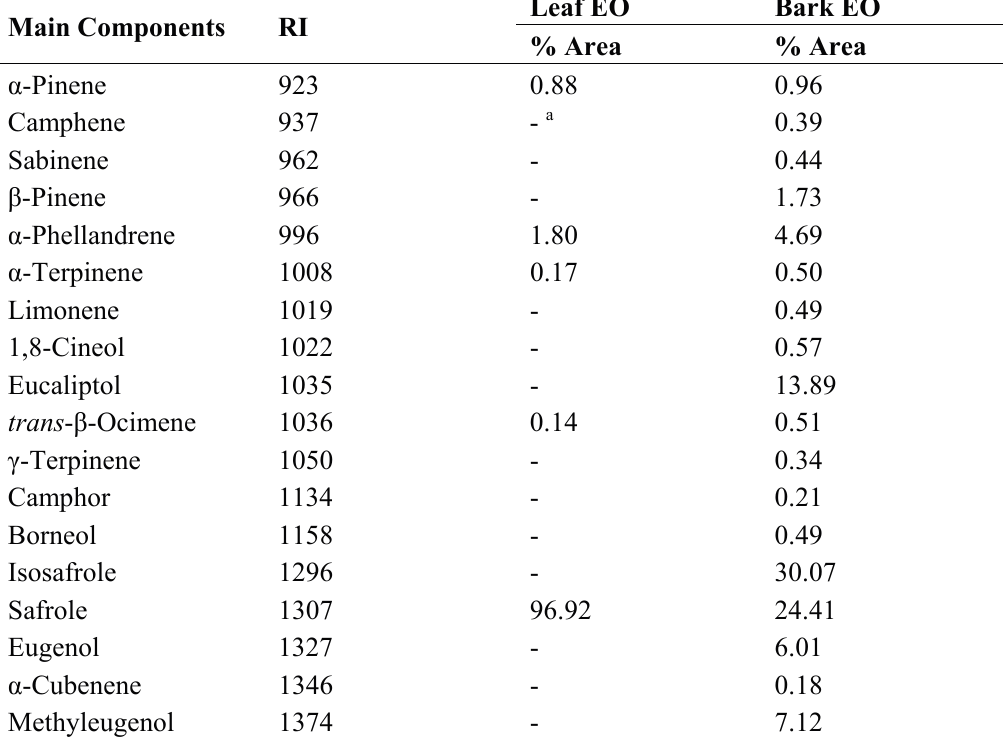
Table 1. Main components of L. philippianna leaf and bark essential oils